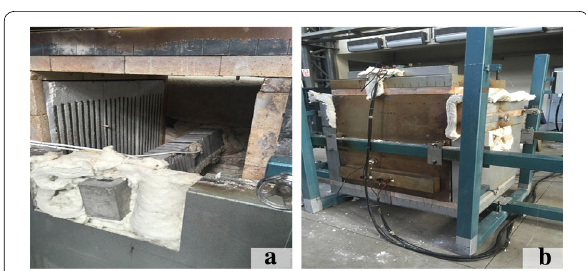
Fig. 4 Equipment of high temperature